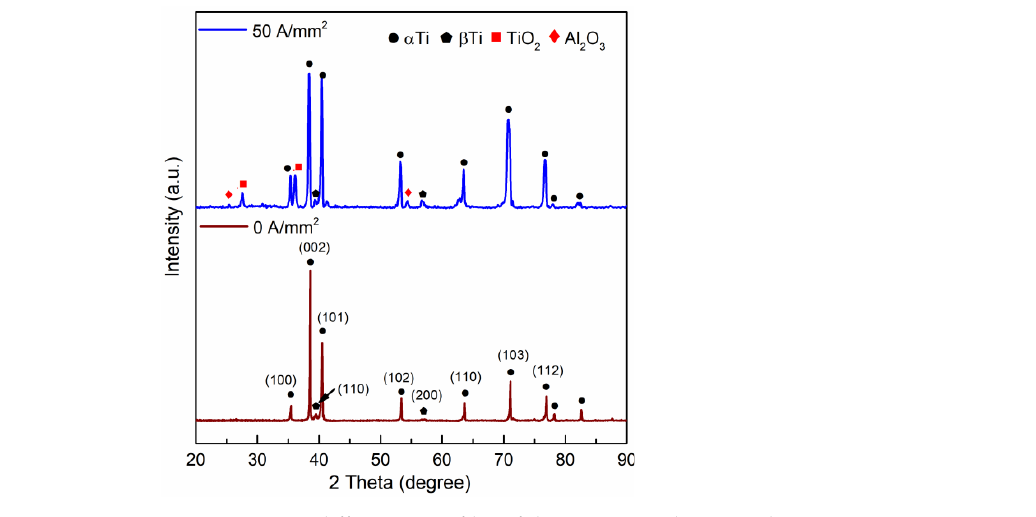
Figure 9. X-ray diffraction profiles of the compressed equiaxed microstructure specimens at different current densities.